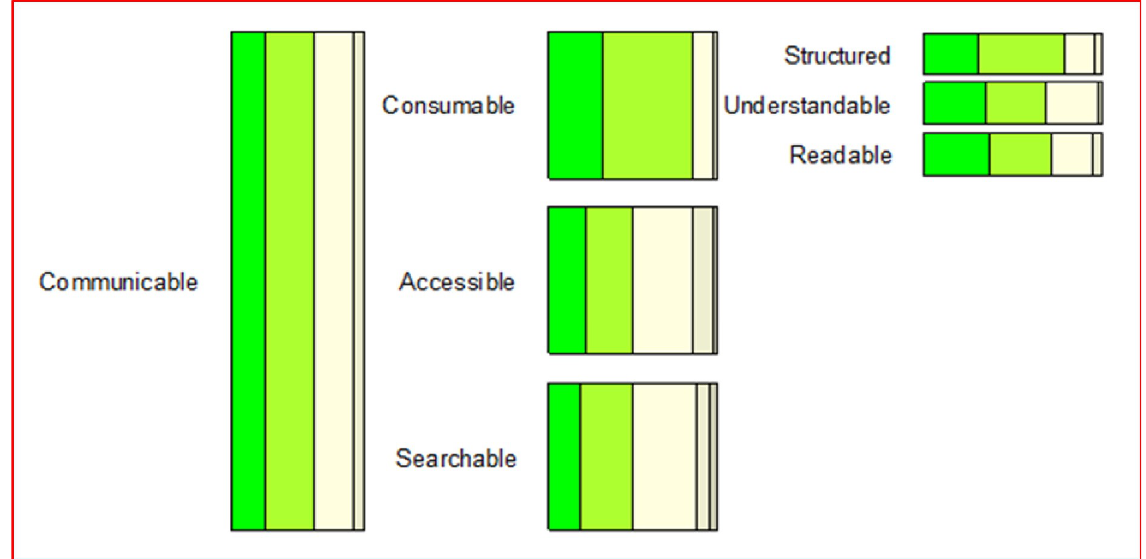
Fig 4. Responses regarding the communicable main concept, ranked from 1–5, where 5 is “of crucial